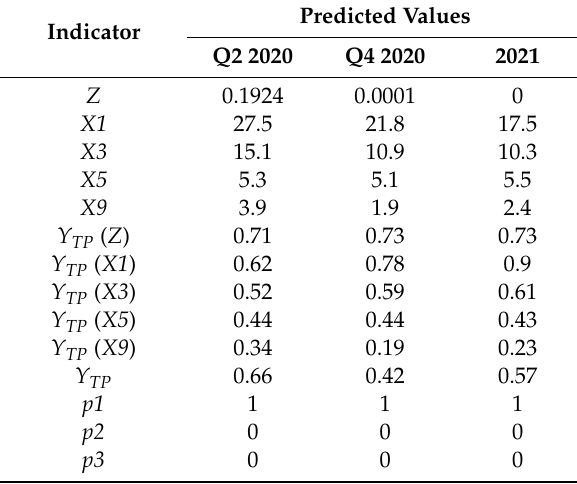
Table 2. Determination of predictive scenarios of the Russian oil industry development in 2020–2021 perspective.